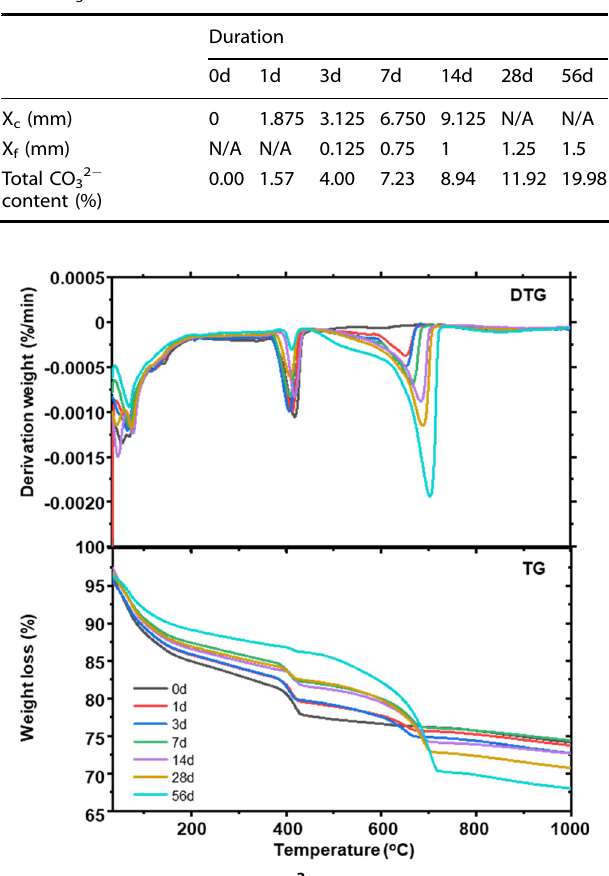
Fig. 5 Quanti fi cation of the CO 32 − content. TG and DTG results for the cement paste specimens.